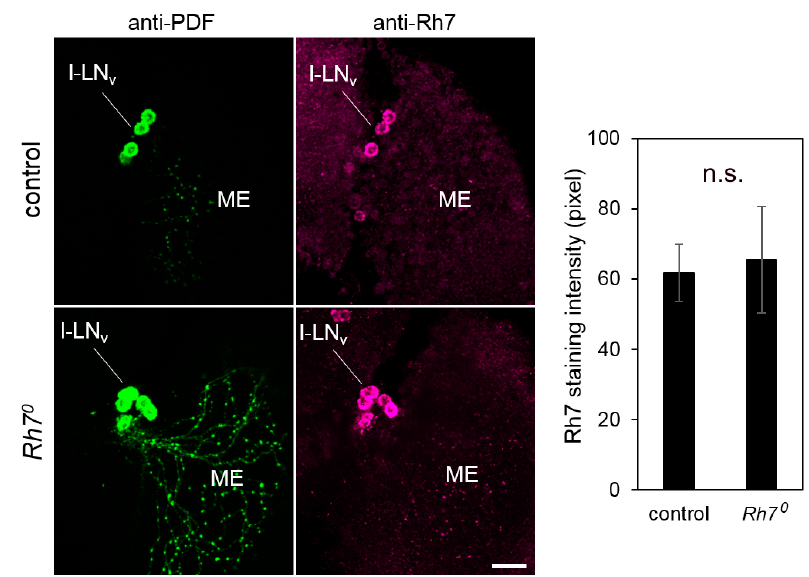
Figure 6. Co-immunostainings with anti-Rh7 and anti-PDF antibodies in the l-LN v cells of the control flies and the Rh7 0 mutants (overlay of five confocal stacks, each). We observed staining of the same intensity in the l-LN v cells of the control flies and the Rh7 0 mutants. The staining was quantified in twelve brain hemispheres of the controls and the mutants, respectively (error bars indicate standard errors of the means). Scale bar: 20 µm.